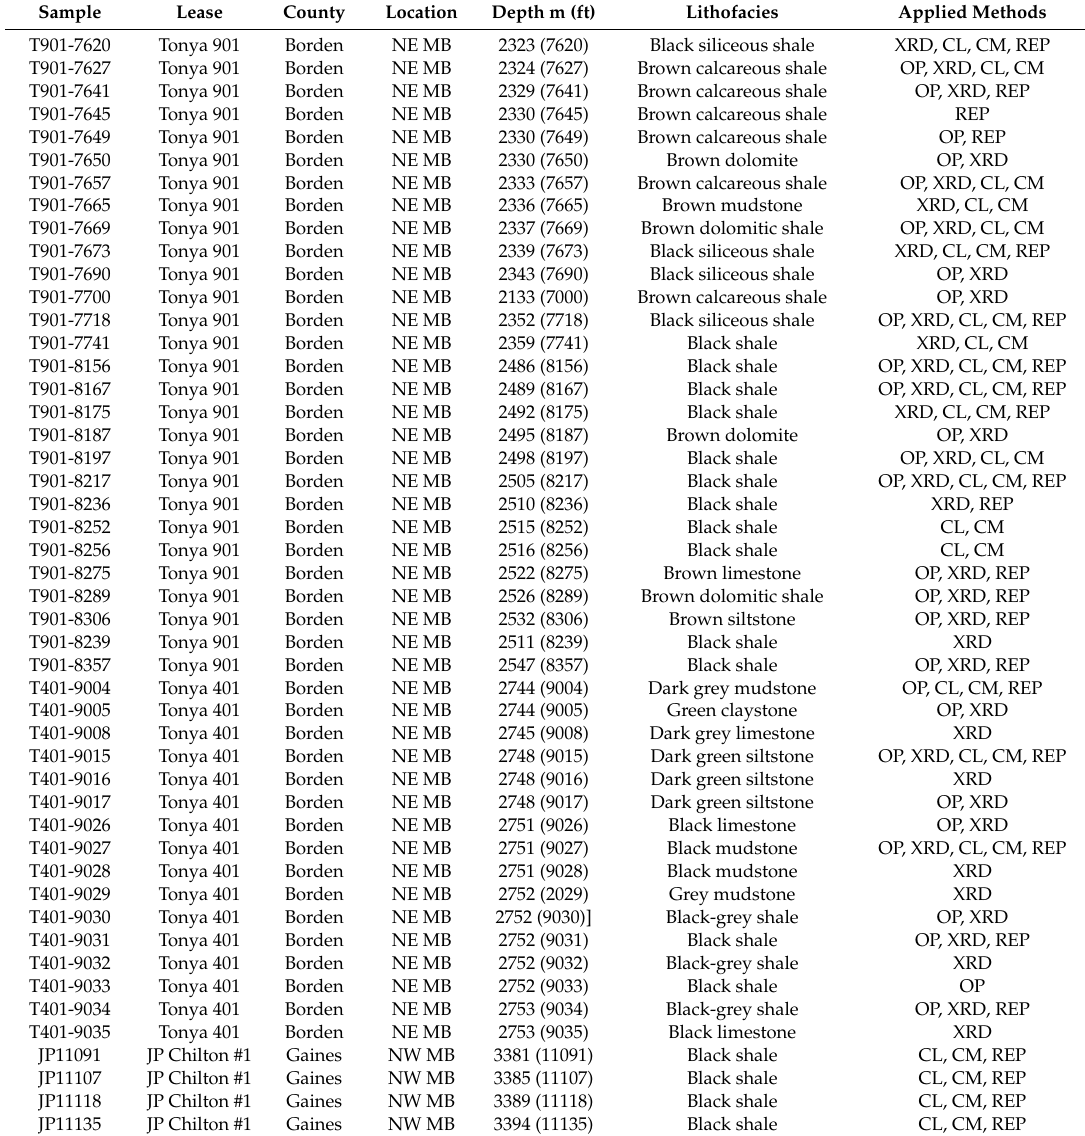
Table 1. List of analyzed drill core samples from multiple wells within the Midland